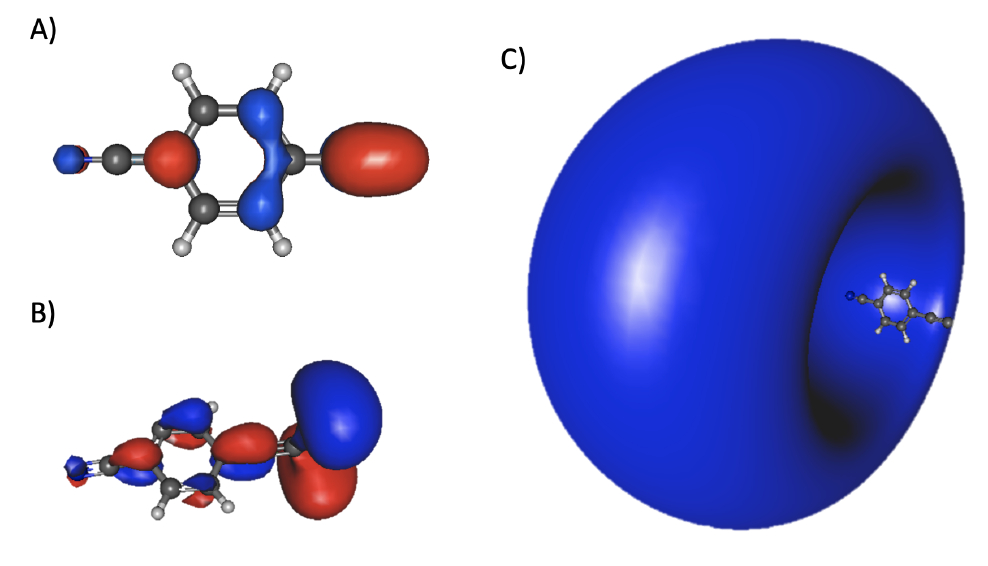
Figure 2. The electronic excited states of cyanoethynylbenzene isomer p-CNC2H-3. ( A ) b 1 highest occupied molecular orbital, ( B ) b 1 valence-bound state, ( C ) a 1 dipole-bound